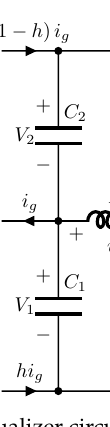
Figure 6. Waveforms of v (cid:48) and i (cid:48) associated with the equalizer circuit for the case V 2 > V 1 .